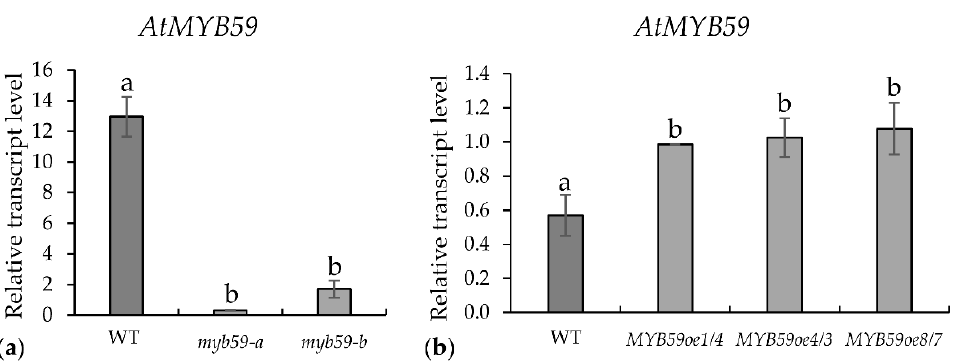
Figure 4. The relative expression levels of the AtMYB59 gene in roots of wild-type (WT), myb59-a and myb 59-b mutants, and MYB59oe overexpression lines: ( a ) relative transcript levels in AtMYB59 mutants roots; ( b ) relative transcript levels in MYB59oe lines. The bars show mean values ± standard deviation. a, b homogenous groups ( p < 0.05; ANOVA; LSD).